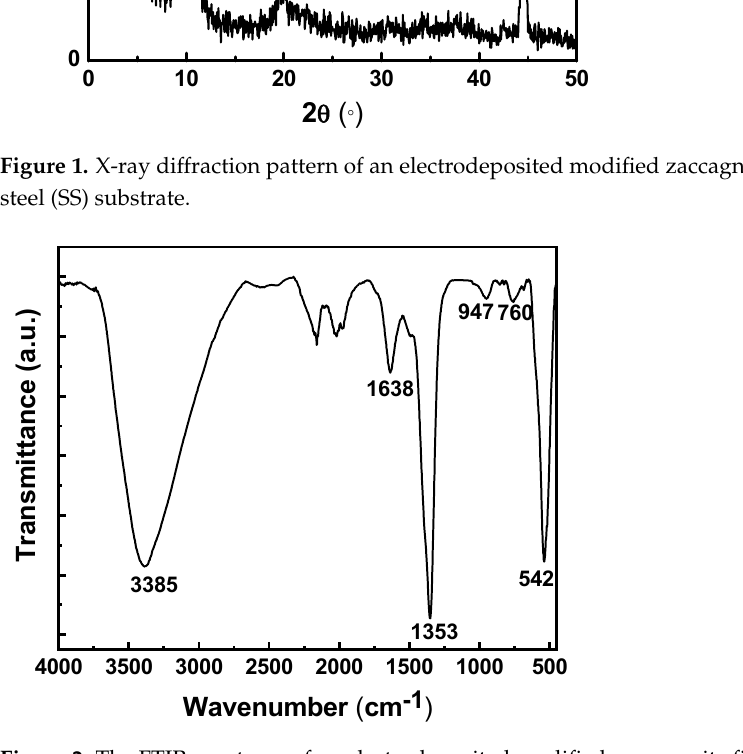
Figure 1. X-ray diffraction pattern of an electrodeposited modified zaccagnaite coating on stainless steel (SS) substrate.